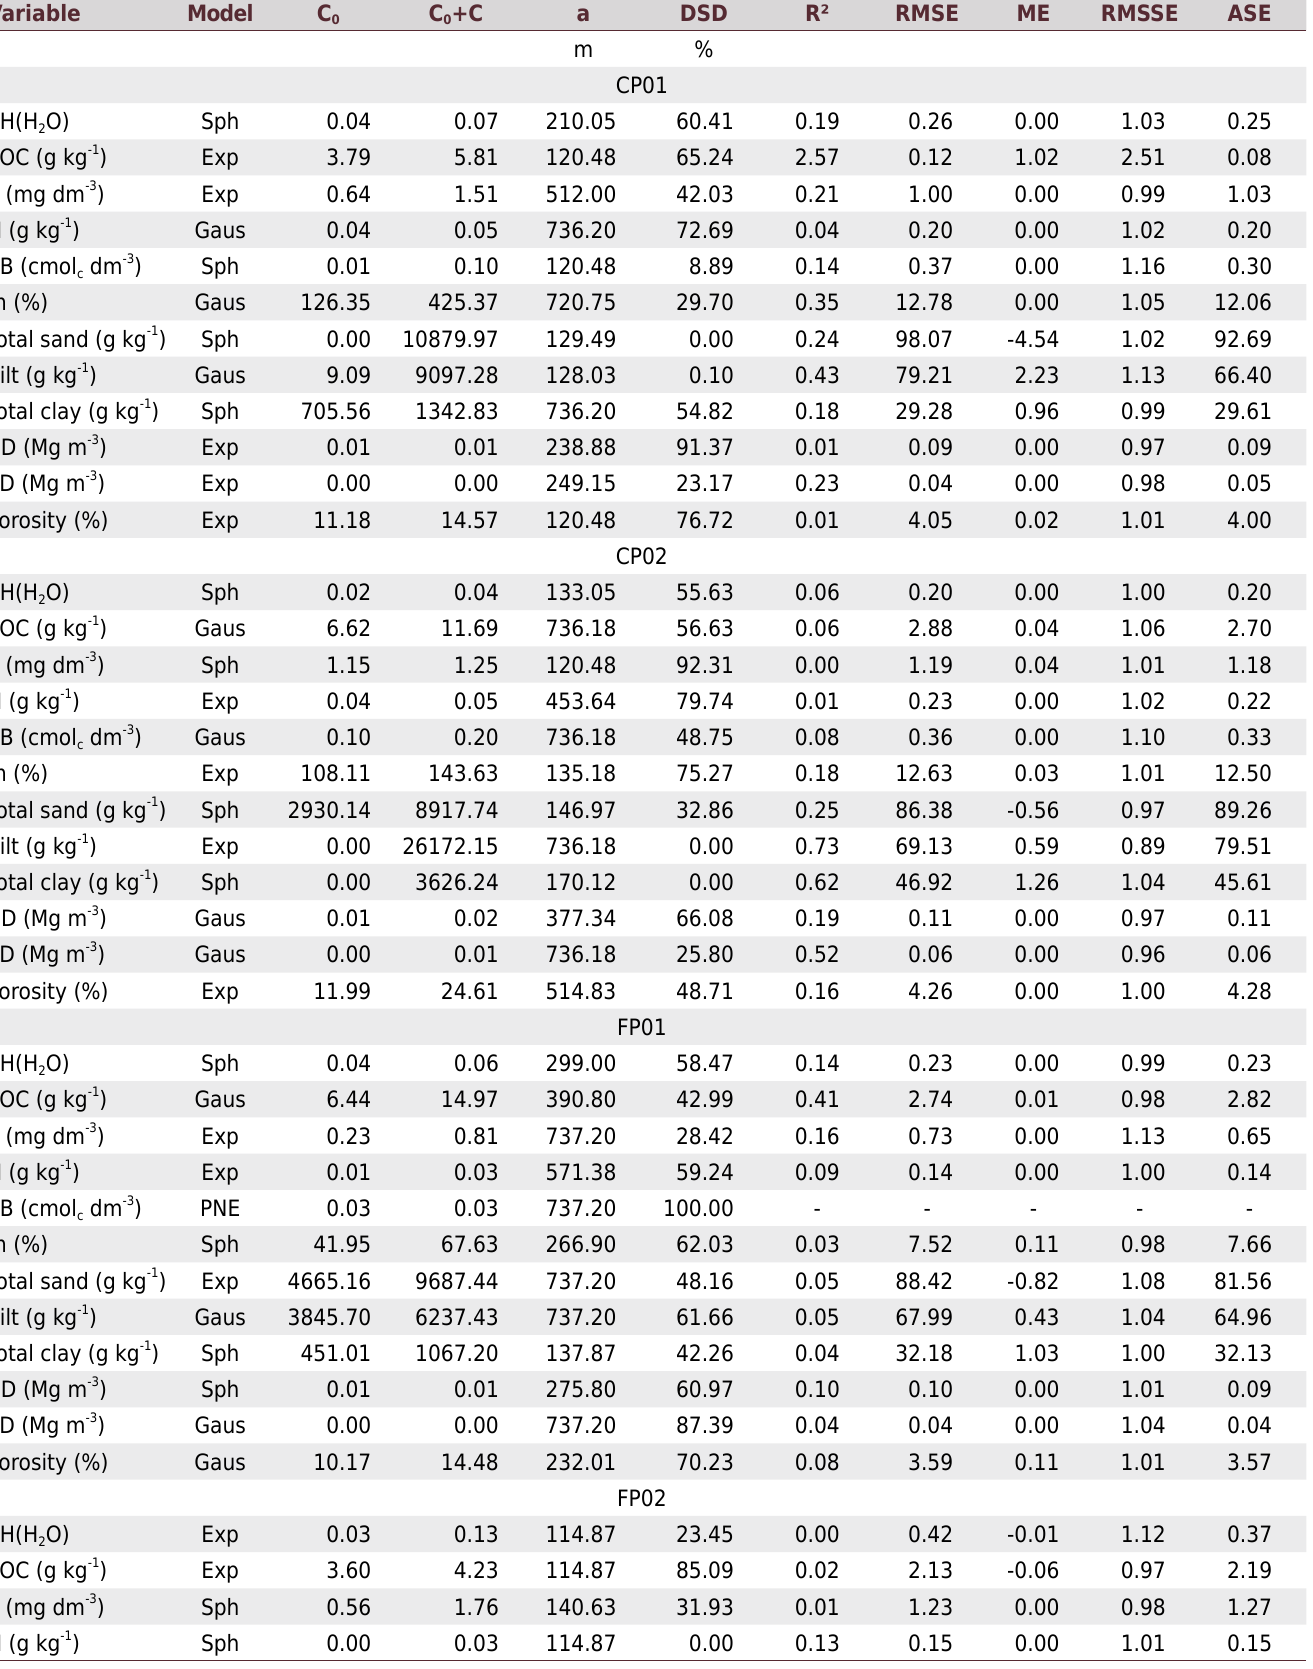
Table 3. Theoretical models fitted and cross-validation for soil physical and chemical properties in four plots of 36 ha each, in two native stands of Brazil nut in the state of Acre, Brazil